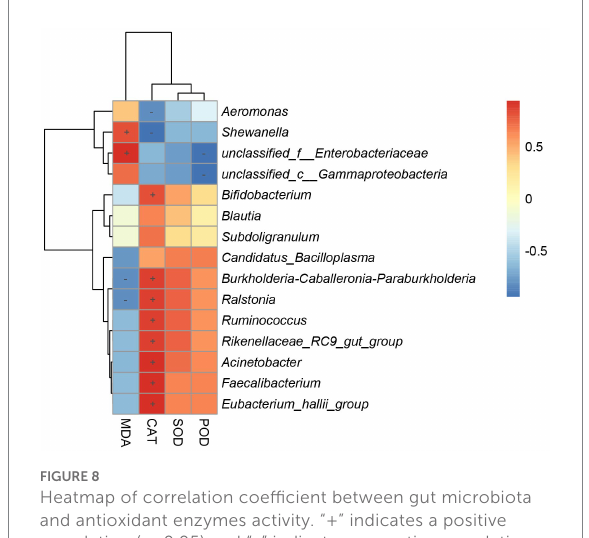
FIGURE 8 Heatmap of correlation coefficient between gut microbiota and antioxidant enzymes activity. “+” indicates a positive correlation ( p < 0.05) and “-” indicates a negative correlation ( p <